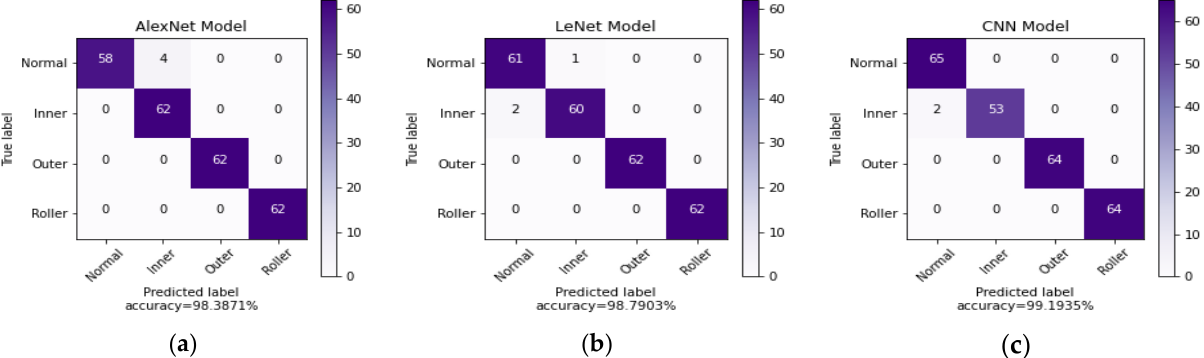
Figure 13. The confusion matrices for three different CNN models ( a ) AlexNet, ( b ) LeNet, and ( c ) our proposed CNN model using the generated 2-D image with the proposed preprocessing method.